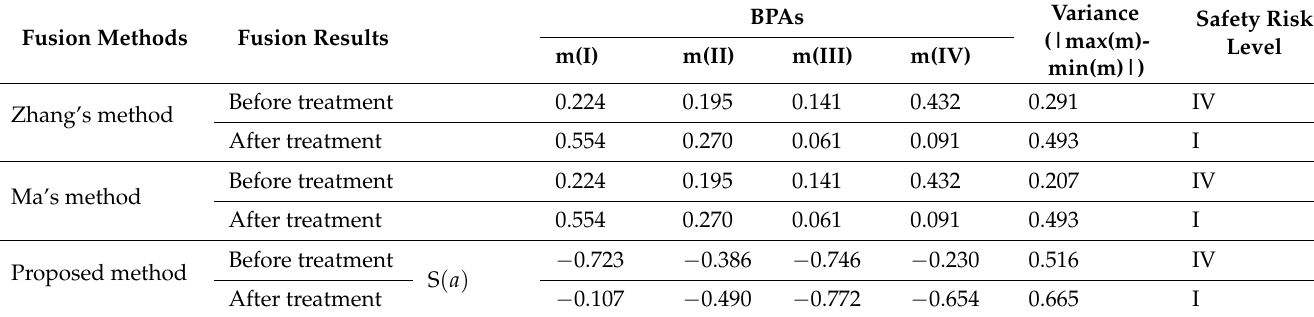
Table 12. Fusion results before and after treatment based on the three